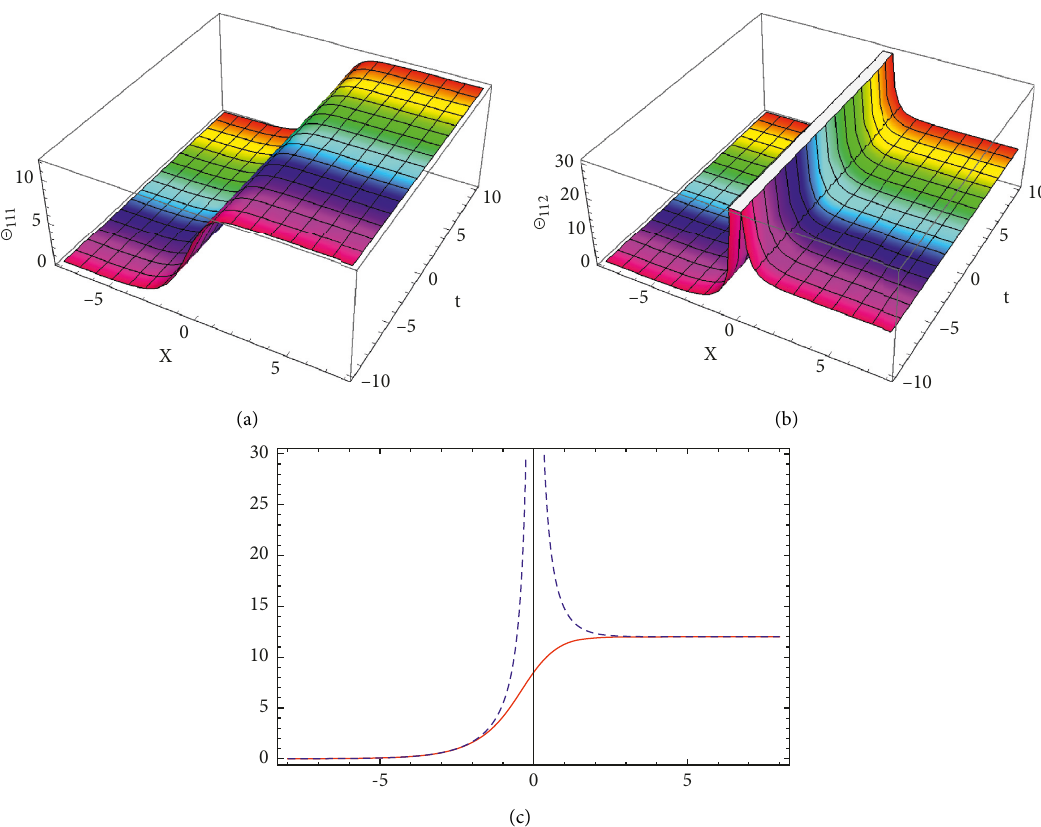
Figure 1: Plots of equations (38) and (39) for m � 2, ξ � 0 . 3, λ